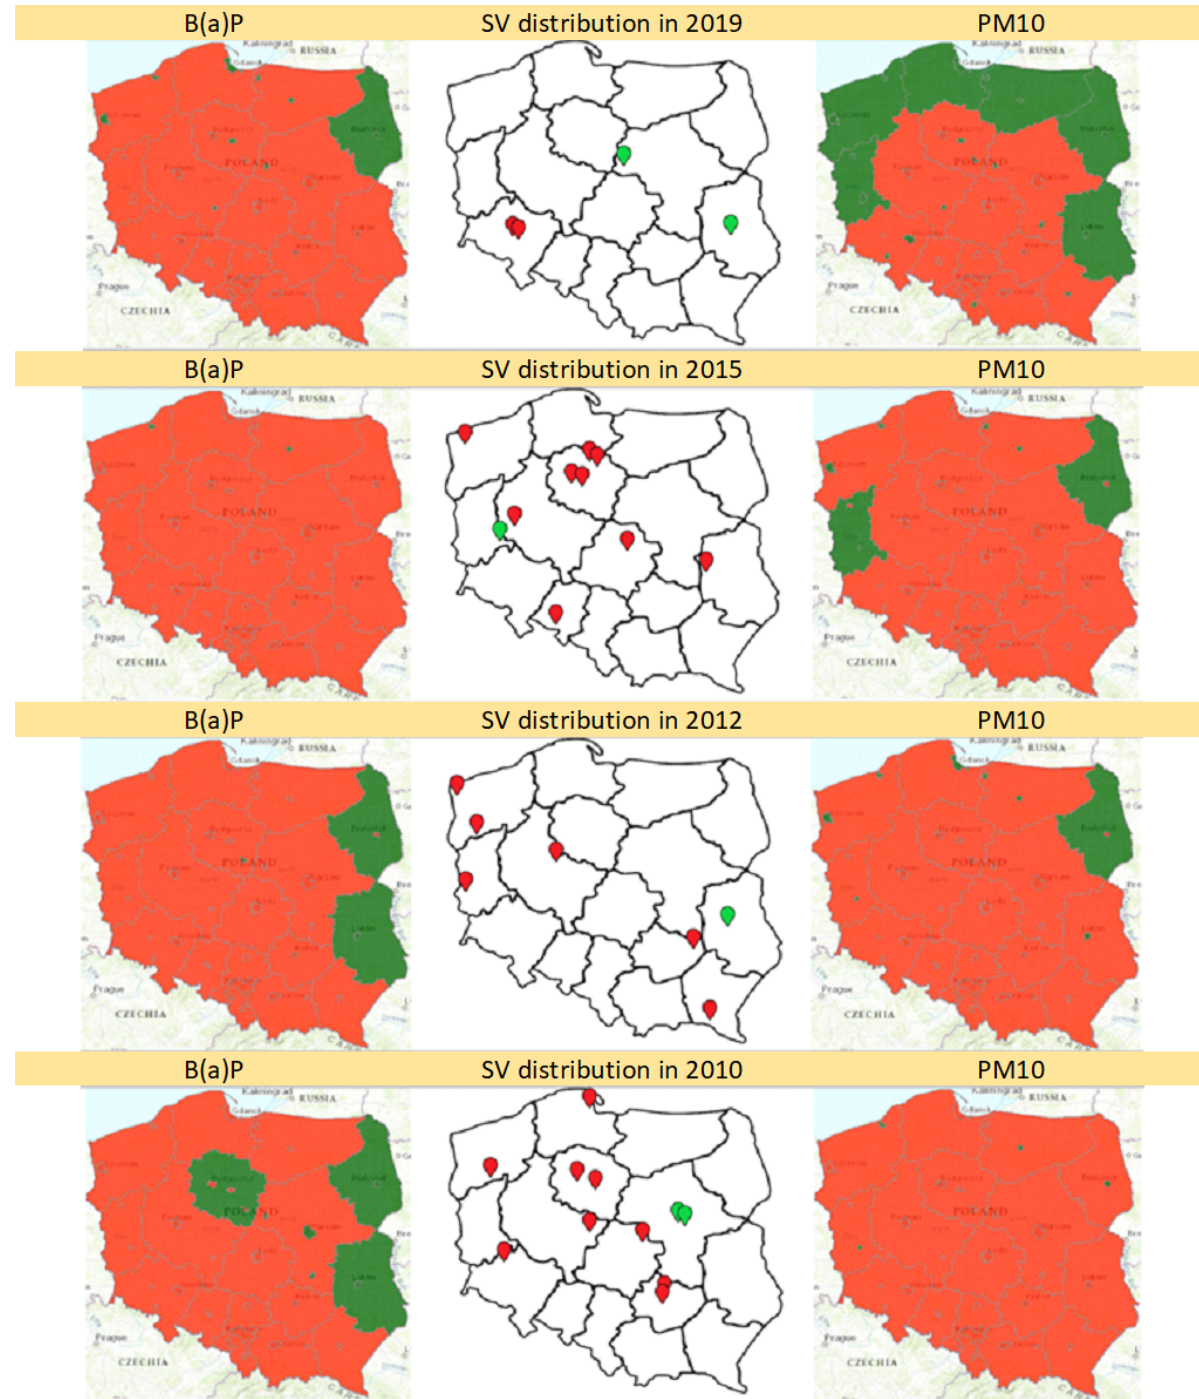
Figure 6. Levels of air pollution (benzo(a)pyrene on the left and PM10 on the right) and territorial distribution of single ventricle cases in years 2019, 2015, 2012 and 2010. The red area corresponds to exceeding the permissible levels, in the green area the concentration of the measured factor is normal. In the middle, the distribution of all single ventricle cases in a given year is marked—the red dots correspond to the cases in the areas where both factors were above the norm and the green ones—where the concentration of at least one of the factors was normal. B(a)P—benzo(a)pyrene, SV—single ventricle.